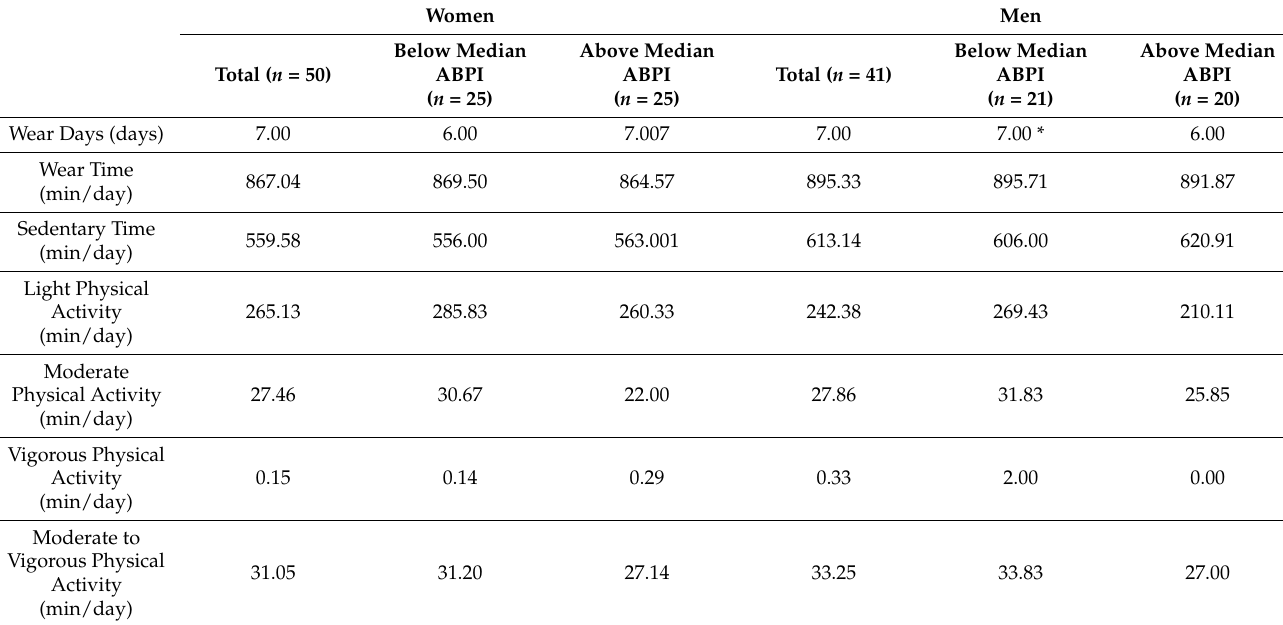
Table 6. Physical activity variables assessed using accelerometry in 41 middle-aged men and 50 middle-aged women.